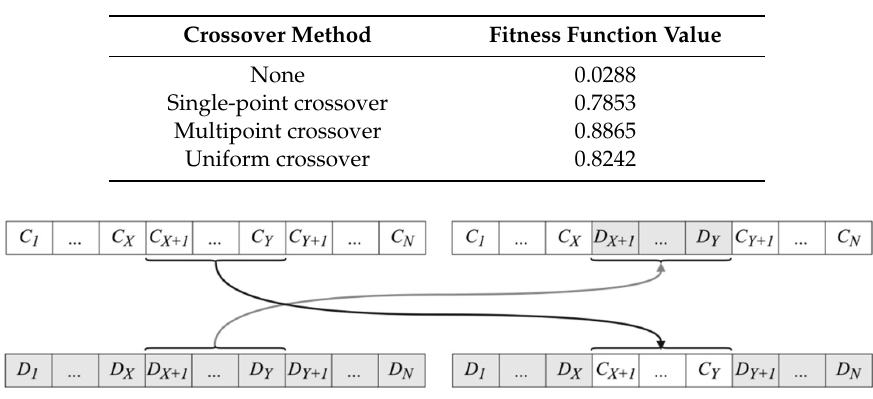
Figure 4. Two-point crossover operation.